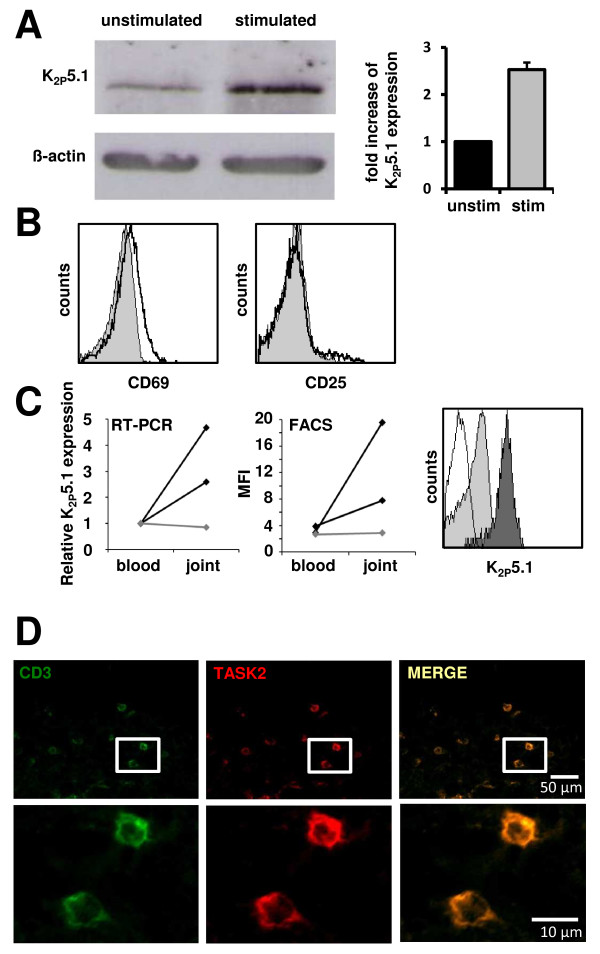
Comparison of CD4+ T lymphocytes derived from peripheral blood and synovial fluid. A) Western blotting of unstimulated and stimulated CD4+ T cells for K2P5.1 and β-actin as loading control (left panel). Quantification of three independent Western blotting experiments (right panel). B) Exemplary flow cytometry stainings for the activation markers CD69 (left panel) and CD25 (right panel) are shown for cells derived from the peripheral blood (grey) and synovial fluid (black). C) K2P5.1 expression levels on CD4+ cells were compared by RT-PCR (left panel) and flow cytometry staining (middle panel). Black lines: RA; grey lines: reactive arthritis. One representative example for RA is depicted on the right side (white: isotyp, grey: peripheral blood, black: synovial fluid). D) Immunohistochemical staining of human synovial tissue sections for CD3 (left panel), TASK2 (middle panel) and overlay (right panel).